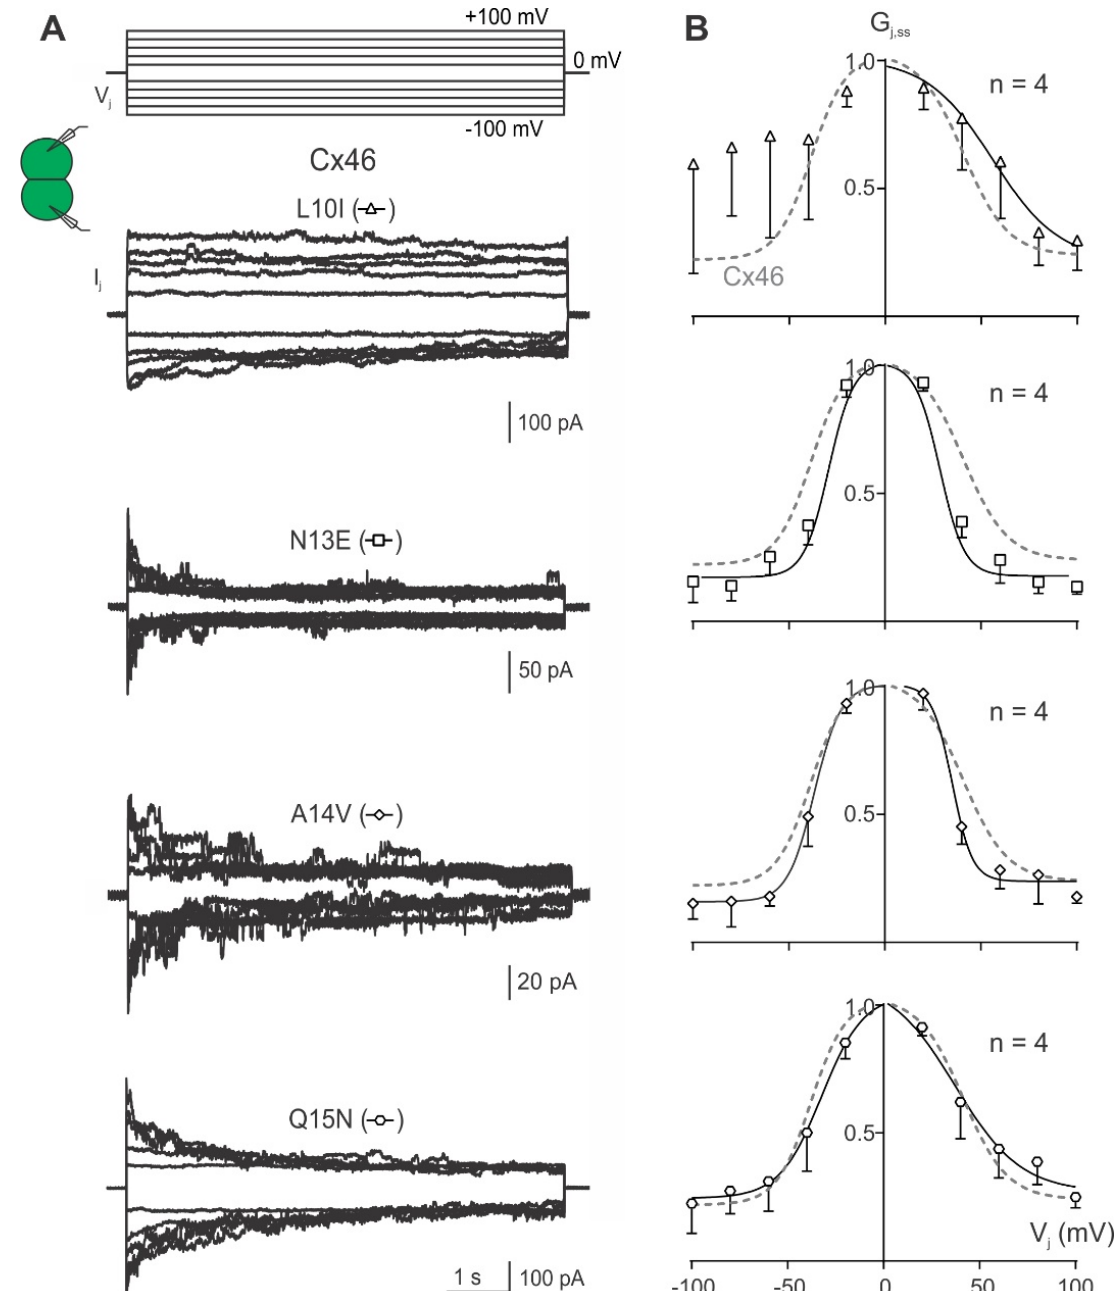
Figure 4. V j -gating properties of GJs formed by Cx46 variants, L10I, N13E, A14V, and Q15N. ( A ) Superimposed I j s from cell pairs expressing L10I, N13E, A14V, and Q15N are illustrated in response to a series of voltage pulses (V j s) ranging from ±20 to ±100 mV in 20 mV increments as shown at the top. ( B ) Normalized steady-state junctional conductance (G j,ss ) plotted against tested V j range for L10I (open triangles), N13E (open squares), A14V (open diamonds), and Q15N (open hexagons) GJs. The Boltzmann fitted curves (smooth solid black lines) for each of the variants are superimposed with those of wild-type Cx46 (smooth dashed grey line) for easy direct comparison. The number of cell pairs for each variant is indicated on each plot. Error bars represent SD.